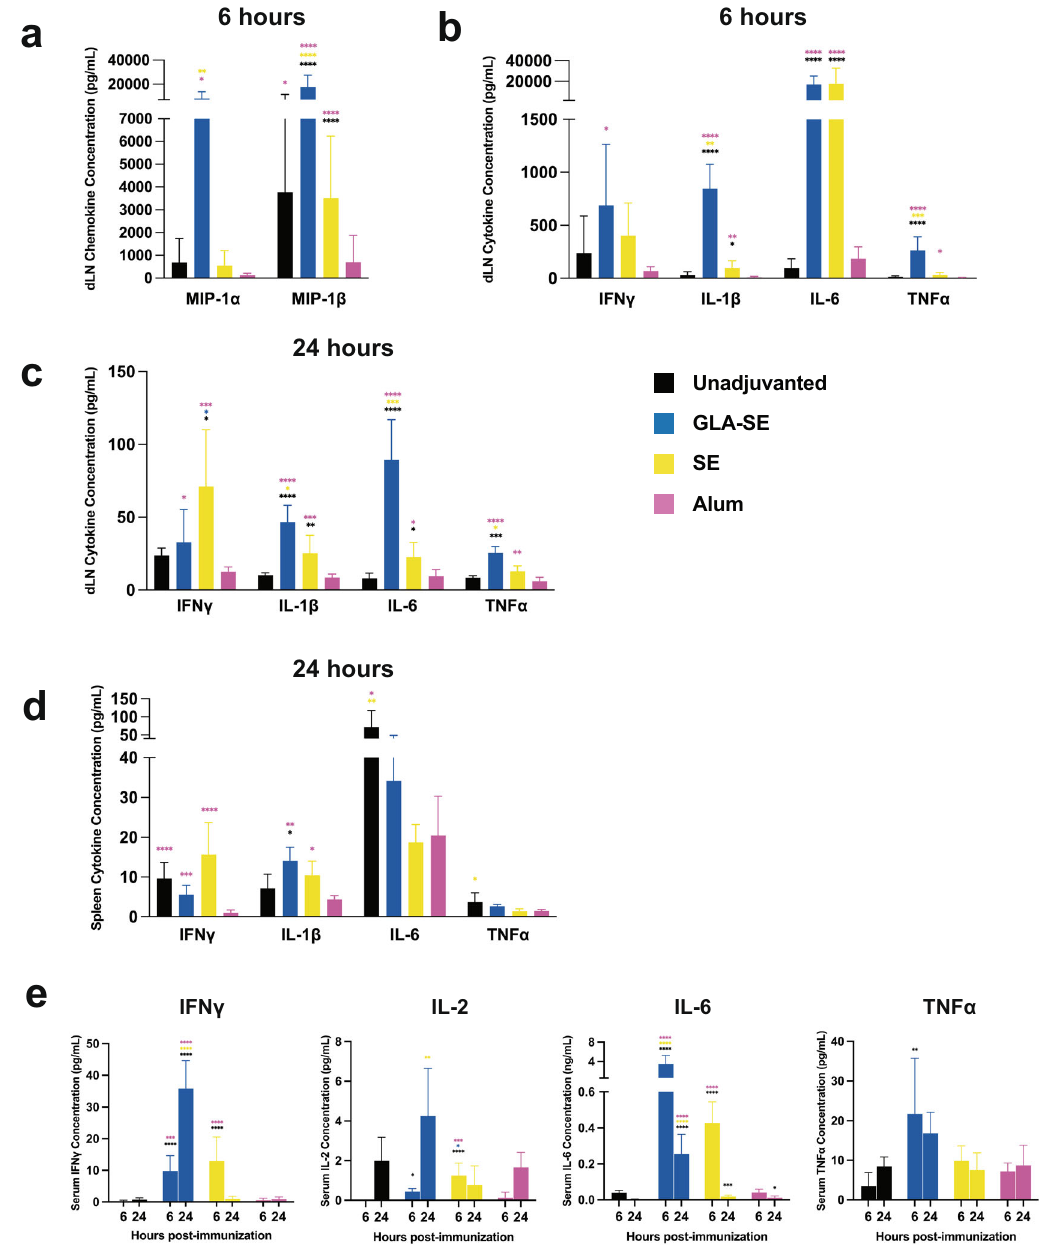
Fig. 3 Rapid chemokine and cytokine levels post-immunization are ampli fi ed by GLA-SE. a Average MIP-1 α and MIP-1 β levels in pg/mL in C57BL/6 mouse dLNs 6 h post-immunization with FILORAB1 and adjuvant formulation (unadjuvanted, GLA-SE, SE, or alum). b IFN γ , IL-1 β , IL-6, and TNF α concentrations in dLNs 6 and c 24 h post-immunization. d IFN γ , IL-1 β , IL-6, and TNF α concentrations from immunized mouse spleens. e IFN γ , IL-2, IL-6, and TNF α concentrations in serum 6 and 24 h post-immunization. Error bars represent SD from the mean. Statistics are by one-way ANOVA with post-hoc Tukey ’ s test of log-transformed concentrations. p > 0.1234 (ns), p < 0.0332 (*), p < 0.0021 (**), p < 0.0002 (***), p < 0.0001